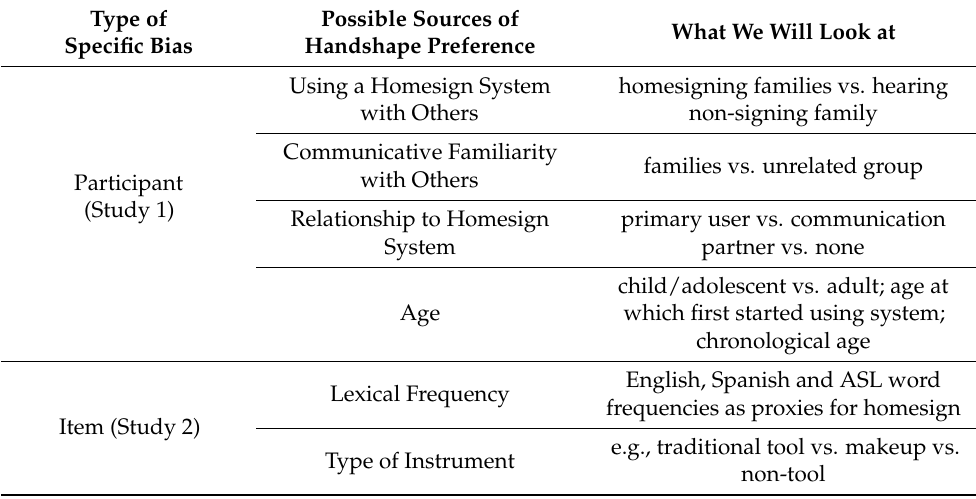
Table 1. Summary of potential sources of handshape preference and conventionalization.